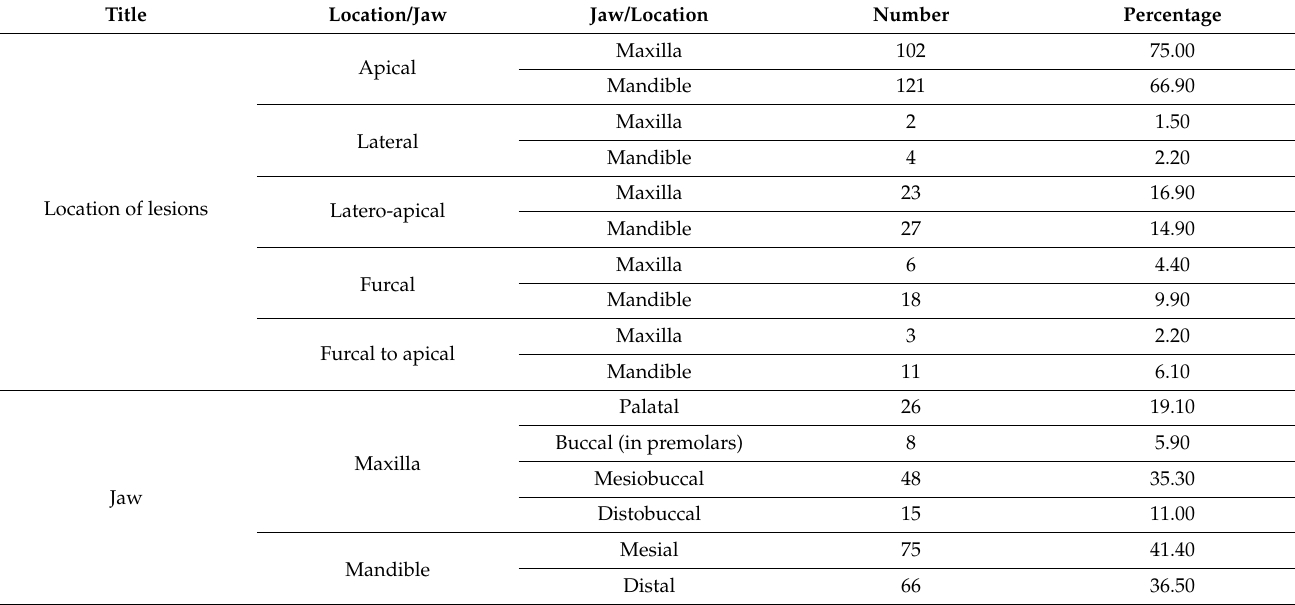
Table 1. Location of lesions and type of root with endodontic lesion.